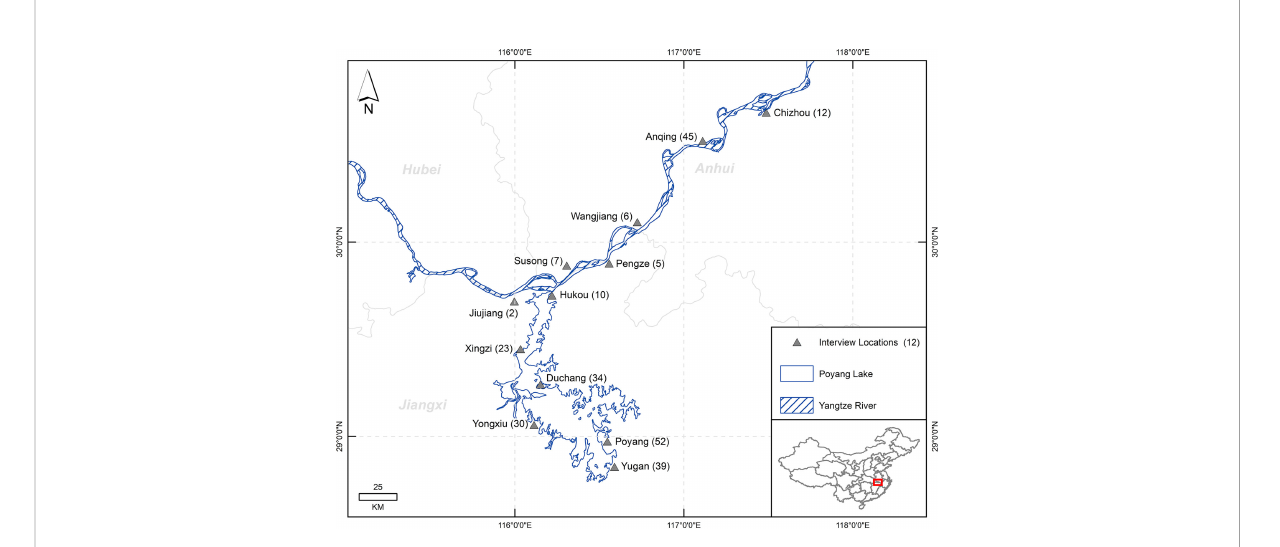
FIGURE 1 Poyang Lake and the adjoining section of Yangtze mainstem, showing fi shing communities where interviews were